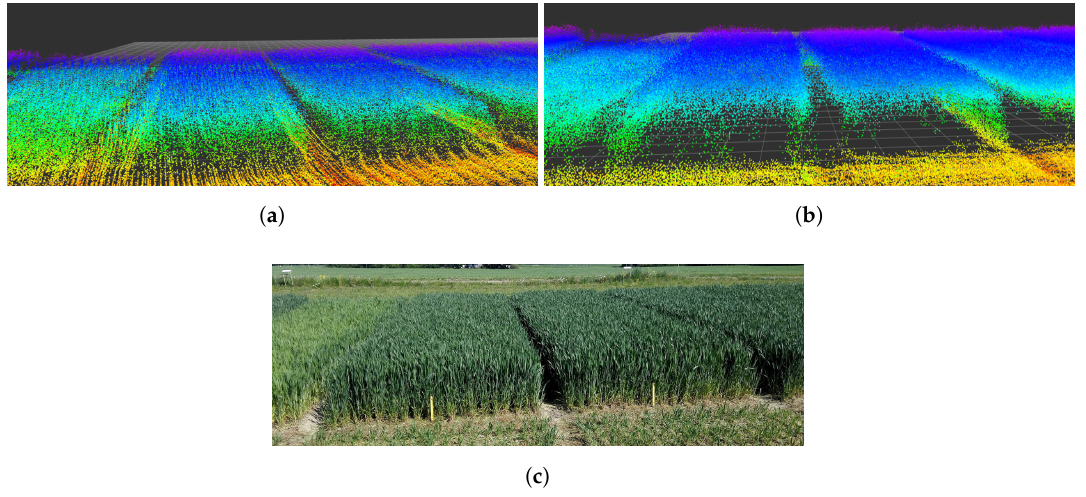
Figure 9. Mapped LiDAR data compared to actual conditions. ( a ) mapping result of flight Path A; ( b ) mapping result of flight Path B; ( c ) photograph of the same area in the experimental